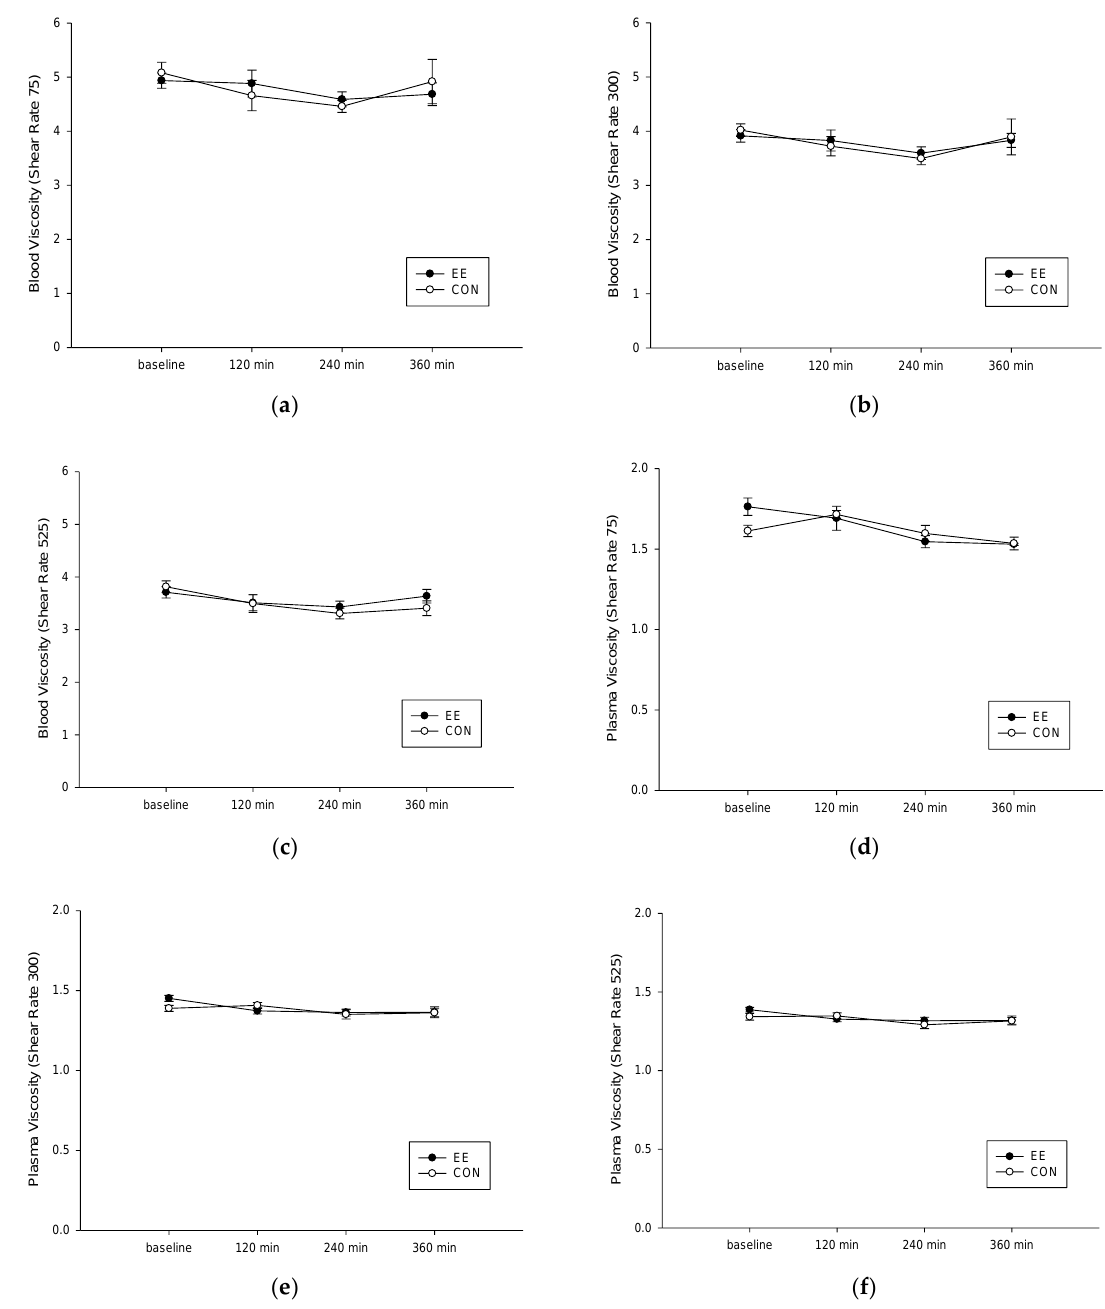
Figure 3. Postprandial blood and plasma viscosity under shear rate of 75 ( a , d ), 300 ( b , e ), and 525 ( c , f ) mPa on the control (CON) ( ○ ) endurance exercise (EE) ( ● ) trials. Values are mean ± SD, n = 8. Table 1. The total cholesterol (TCHO), high-density lipoprotein (HDL), low-density lipoprotein (LDL), malondialdehyde (MDA), and total protein (TP) levels in the blood plasma.